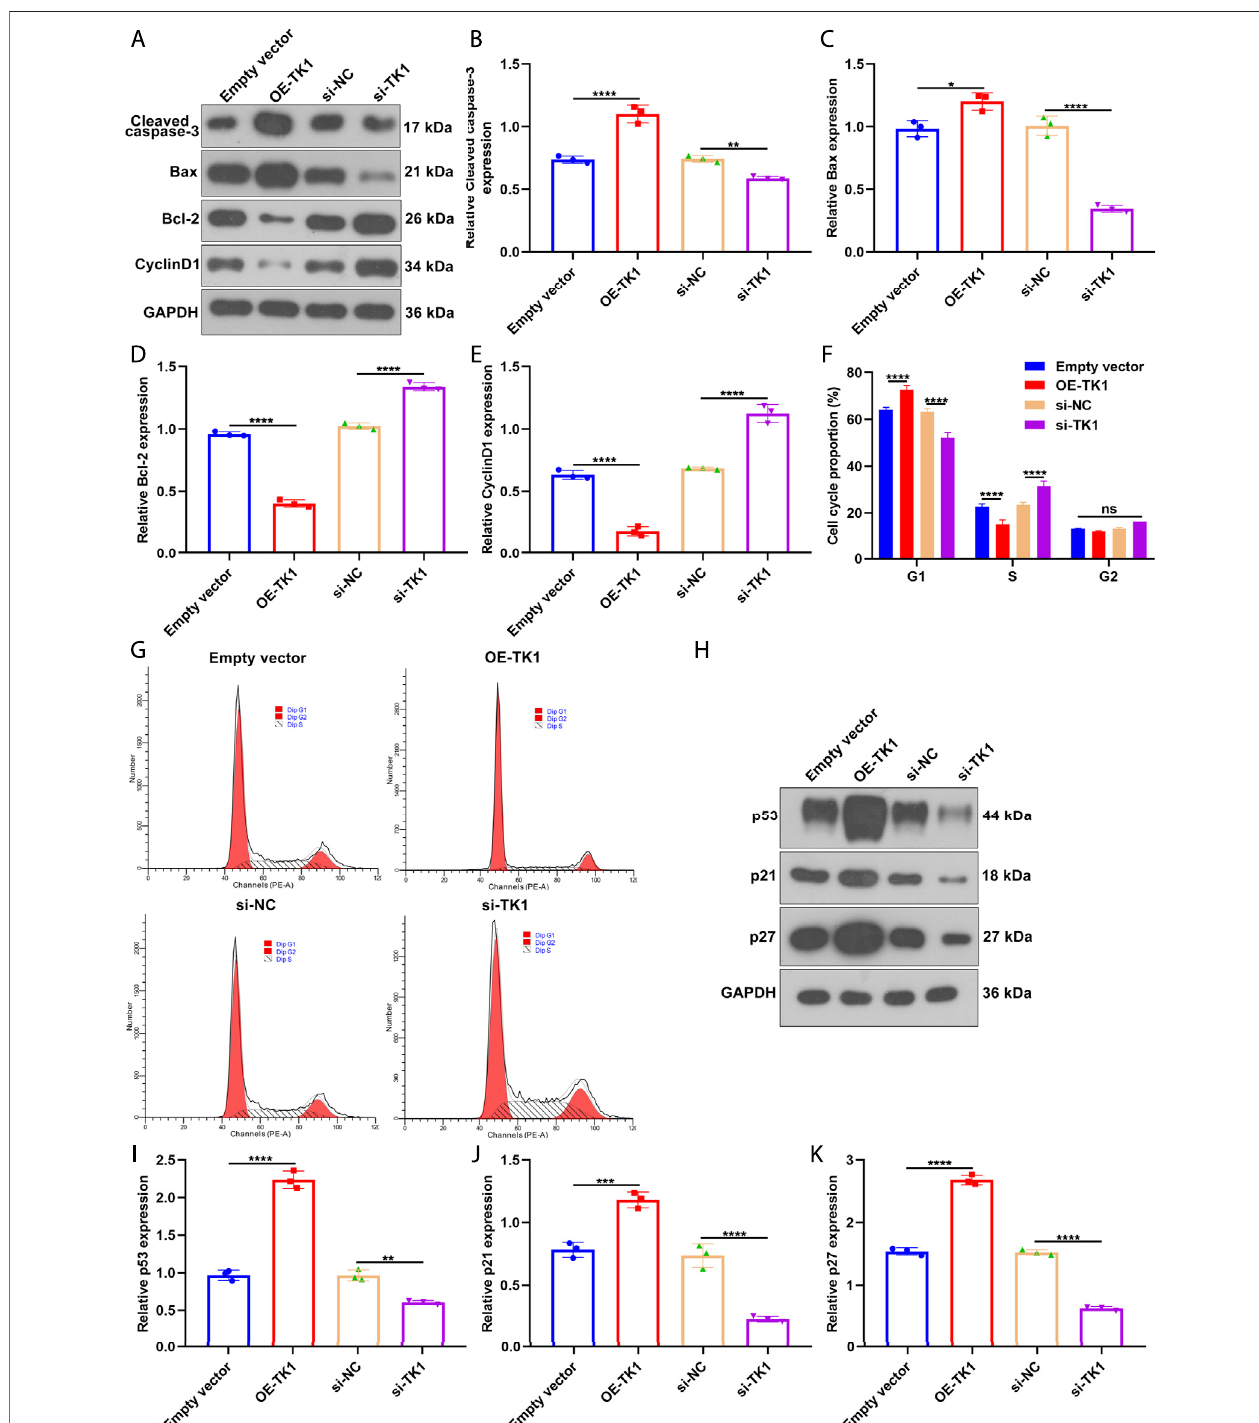
FIGURE 9 | TK1 knockdown relieves apoptosis, cell cycle arrest and senescence in SLE BMSCs. (A – E) The expression of cell cycle- and apoptosis-relevant proteins was measured in SLE BMSCs with TK1 overexpression or TK1 knockdown through western blotting, containing (B) Cleaved caspase-3, (C) Bax, (D) Bcl-2 as well as (E) CyclinD1. (F,G) Cell cycle proportions were tested in speci fi ed SLE BMSCs via fl ow cytometry analyses. (H – K) The expression of senescence-relevant proteins was measured in speci fi ed SLE BMSCs. Ns: not signi fi cant; * p < 0.05; ** p < 0.01; *** p < 0.001; **** p < 0.0001.